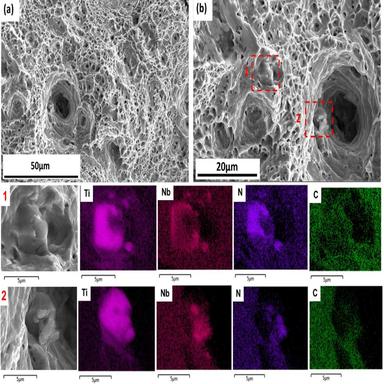
SEM microscopic image of sample fracture surface after tensile test at room temperature (a), dimple structure and cavities can be noticed. SEM image zoomed in the cavity structure. Micrometric scale precipitates rich in Nb, Ti and N are found on the edge of cavities (b).